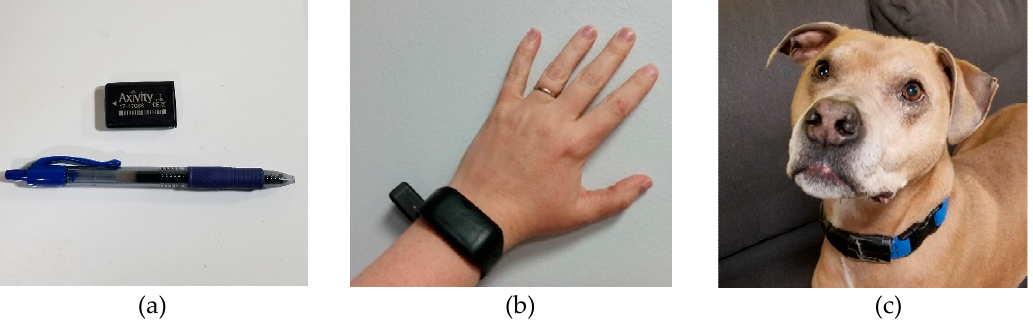
Figure 1. Study equipment. The figure on the left ( a ) shows the size of the Axivity AX3 in relation to an ink pen; the middle figure ( b ) shows how the Axivity AX3 was housed inside a wristband that human participants wore; and the figure on the right ( c ) shows the Axivity AX3 attached to the dog’s collar.